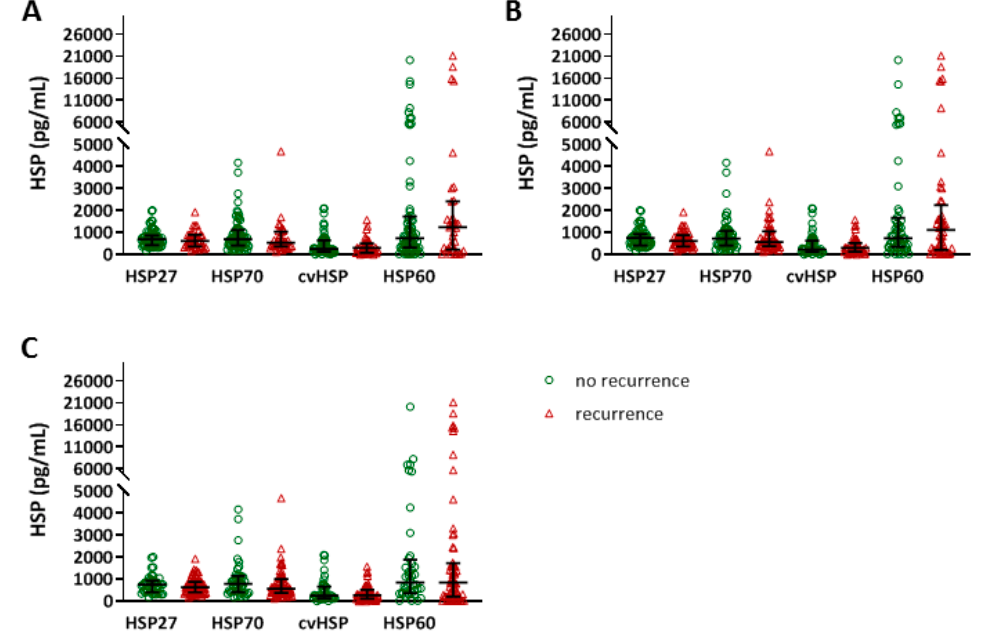
Figure 3. No differences in baseline HSP27, HSP70, cvHSP or HSP60 serum levels between patients with and without AF recurrence after PVI. HSP27, HSP70, cvHSP and HSP60 serum levels (pg/mL) at baseline, comparing patients with and without AF recurrence within 3 months ( A ), 6 months ( B ) and 1 year ( C ) after pulmonary vein isolation (PVI) treatment.